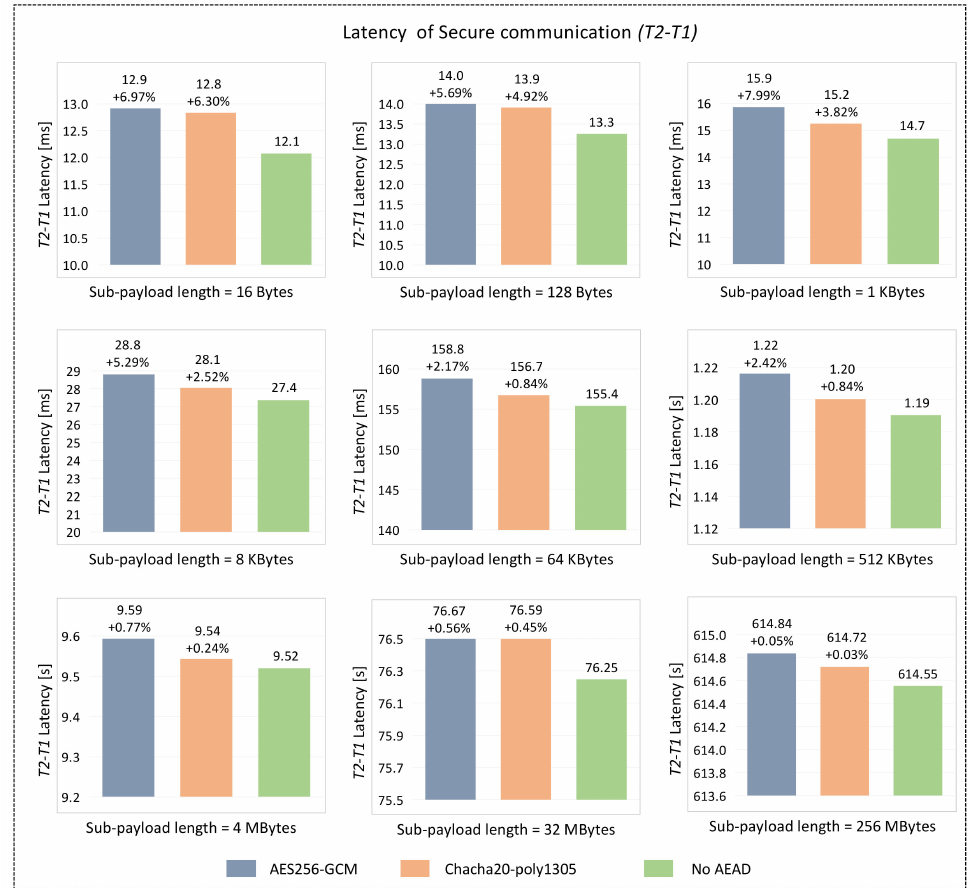
Figure 12. Latency of the designed secure communication